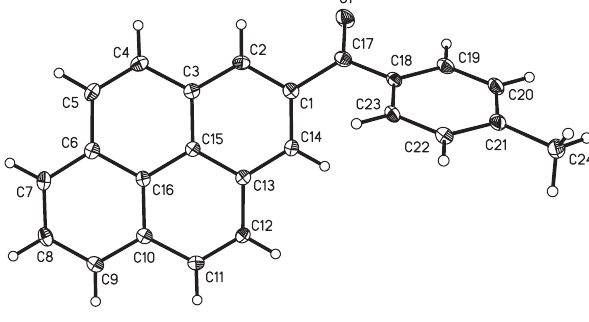
Table 1: Data collection and handling.